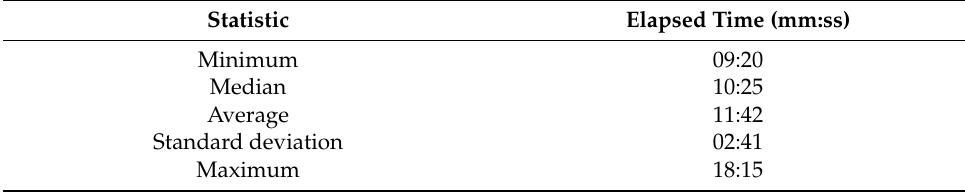
Table 6. A statistical overview of elapsed inspection time for successful inspections.